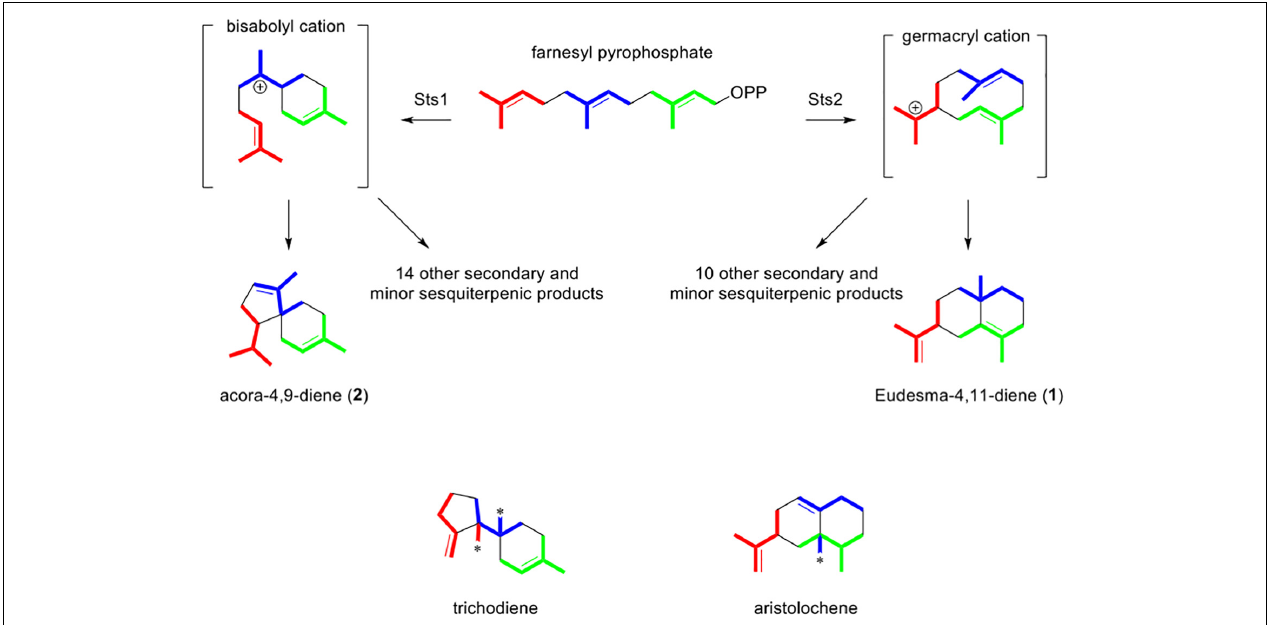
FIGURE 7 | Folding pattern of farnesyl pyrophosphate (FPP) in P. nodorum Sts1 and Sts2. Color indicate the different isoprene units. Asterisks in methyl groups of trichothecene and aristolochene indicate a rearrangement and the color indicates to which isoprene unit it